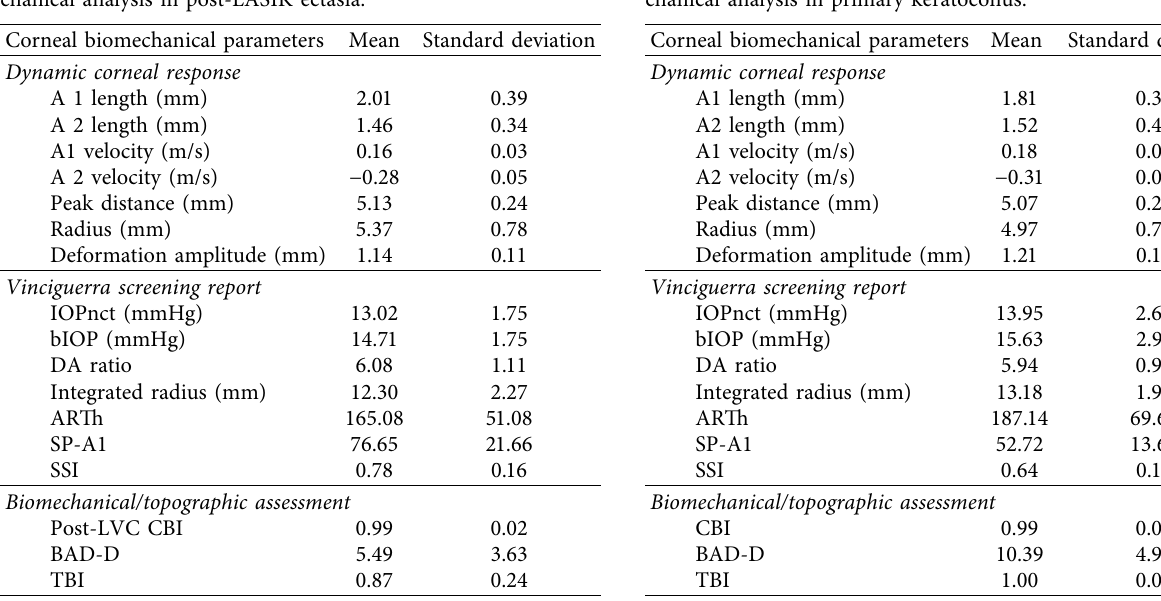
Table 4: Corvis ST combined with Pentacam for corneal biome- chanical analysis in primary keratoconus.